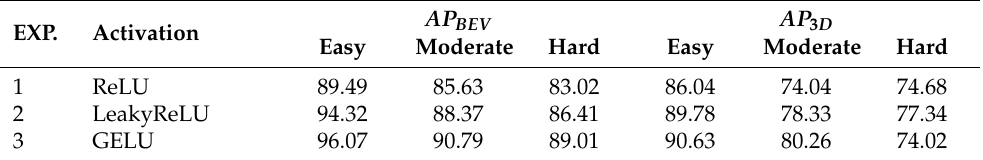
Table 3. The ablation study for activation function on car category (%).